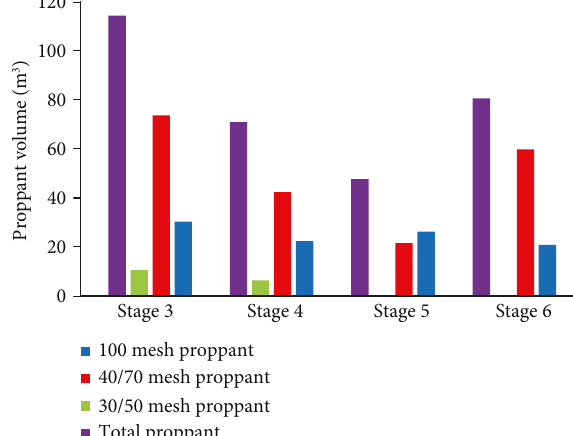
Figure 16: Proppant parameters of the refracturing